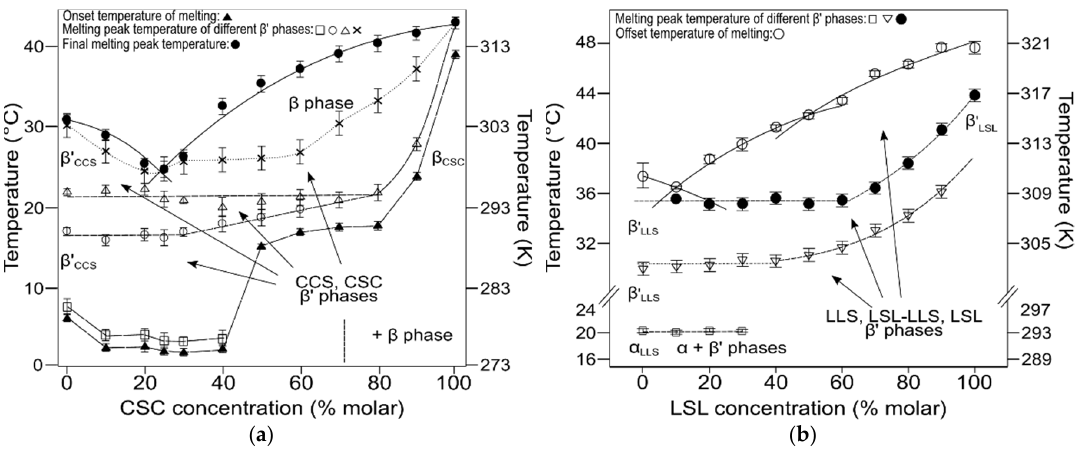
Figure 5. Kinetic phase diagrams of ( a ) CSC/CCS and ( b ) LSL/LLS binary systems obtained during cooling at 3 °C·min − 1 and subsequent heating at 5 °C·min − 1 . For simplicity, the multiple β ’ forms are represented by β ’. Reproduced with permission from [88,89], © 2008, 2010 Elsevier. Table 3. Phase behavior in binary mixtures of mixed-acid tri-saturated As for LSL/LLS mixtures, the kinetic phase diagrams showed the presence of a singularity at a Χ LLS of 50%, which consisted of a clear change of slope in the liquidus curve, delimiting two distinct